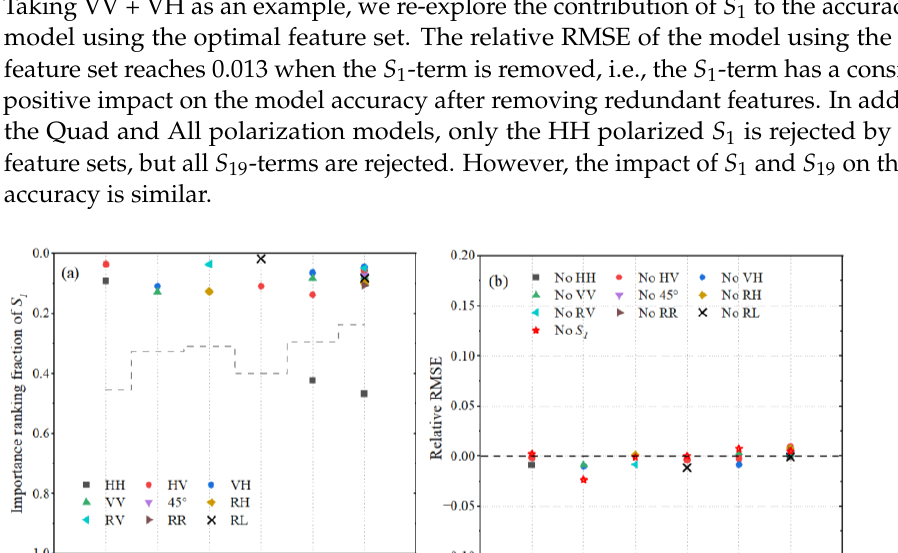
Figure 28. The importance of S 19 to SWH retrieval from single-polarization models. ( a ) The im- portance ranking of S 19 provided by XGBoost models normalized to 0 – 1. The dotted line represents the optimal feature sets under different polarizations. ( b ) The effect of removing S 19 on the SWH estimation from different polarized models. Different markers in various colors represent S 19 of dif- ferent polarizations. ( c ) The correlation between S 19 and ERA5 SWH under different polarizations.